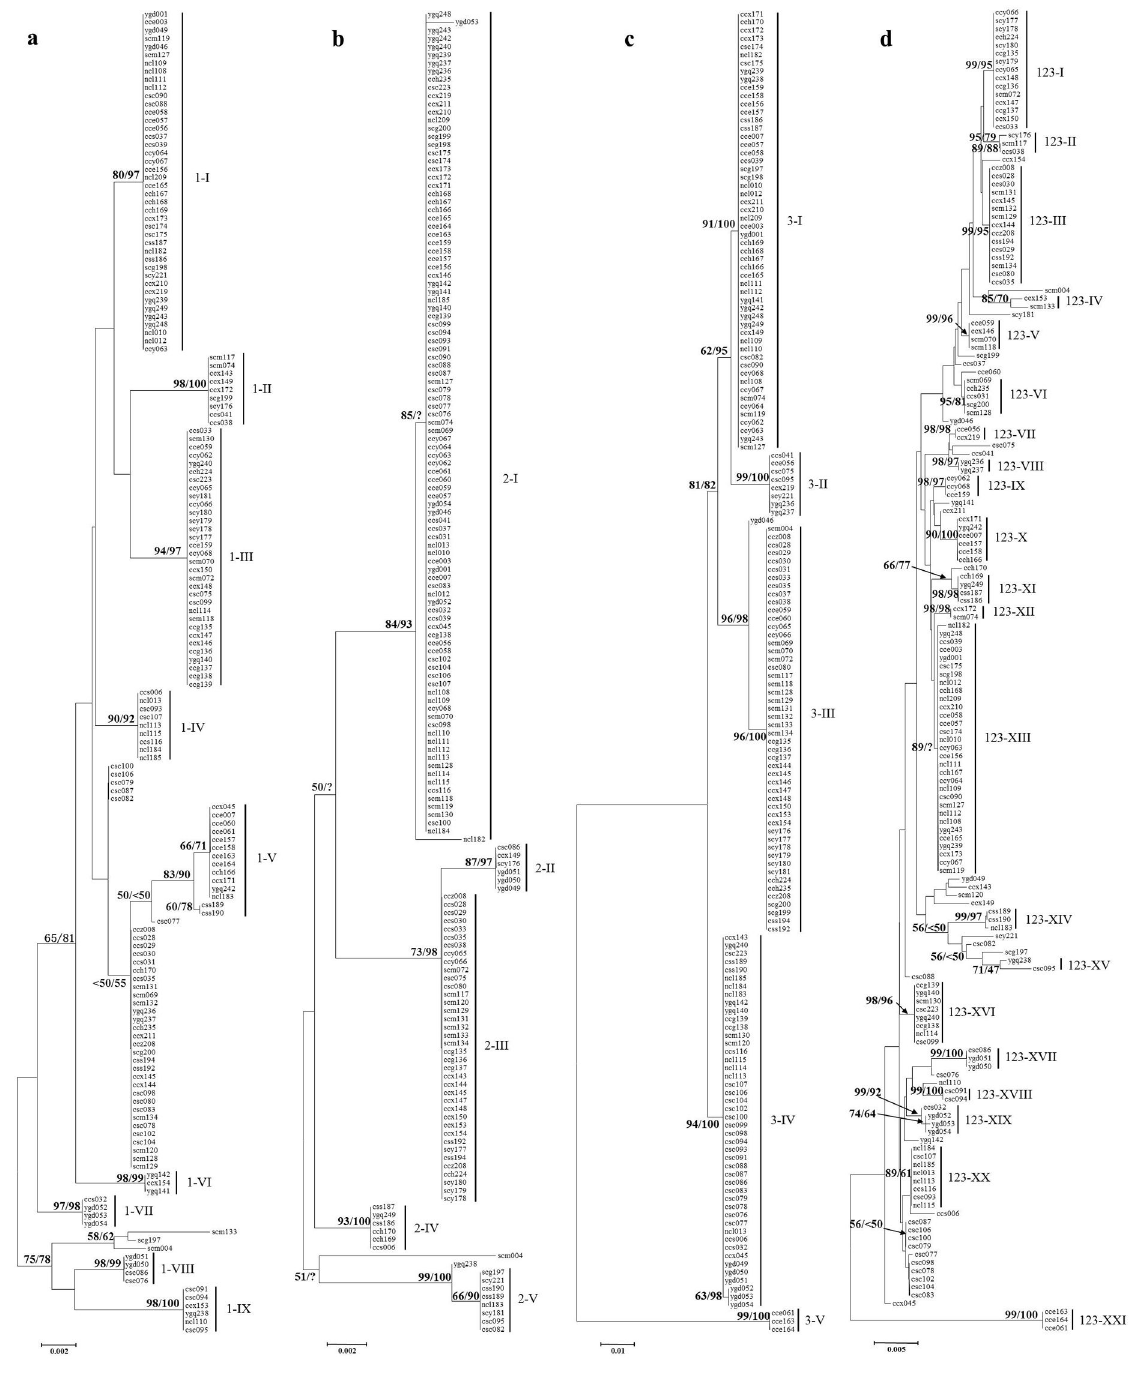
Figure 3. Phylogenetic analyses based on sequences at individual marker (a–c) or the combined sequences at three markers (d). NJ and ML phylogenetic analyses were conducted based on DNA sequences at Marker 1(a), Marker 2 (b), Marker 3 (c) and the combined sequences at the three markers (d). The two methods gave almost identical topologies. Nodal support values for NJ (before the slash) and ML analysis (after the slash) are given for branches receiving more than 70% support. Clades were named with marker names and Roman